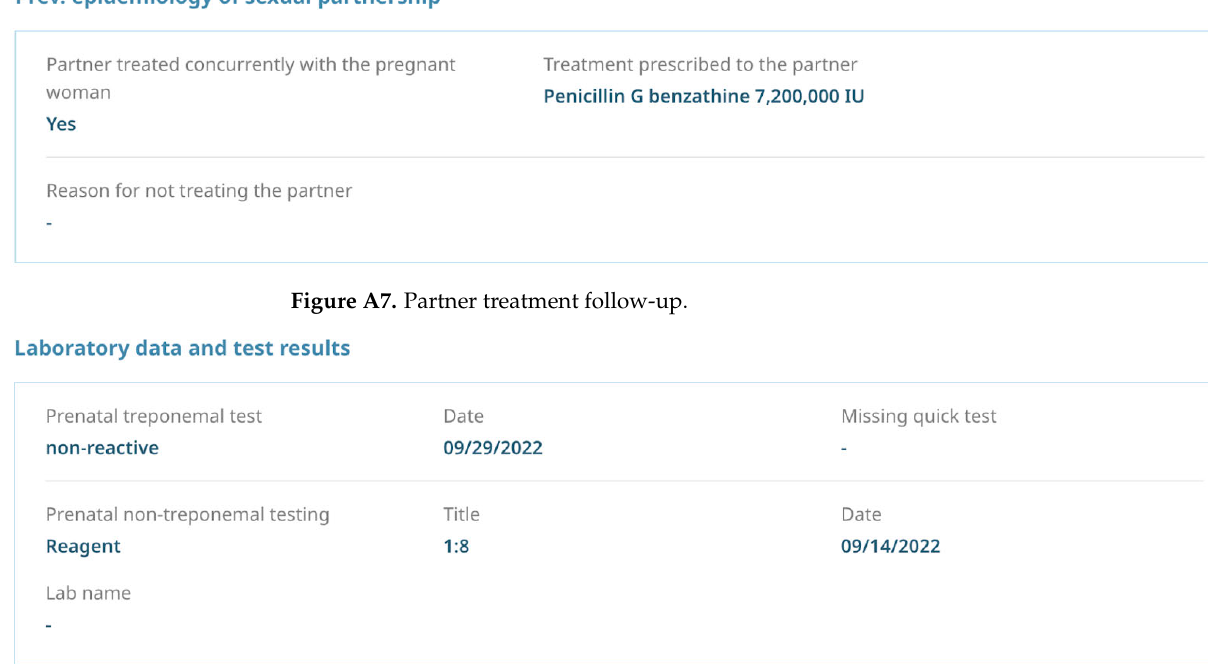
Figure A8. Exam results.